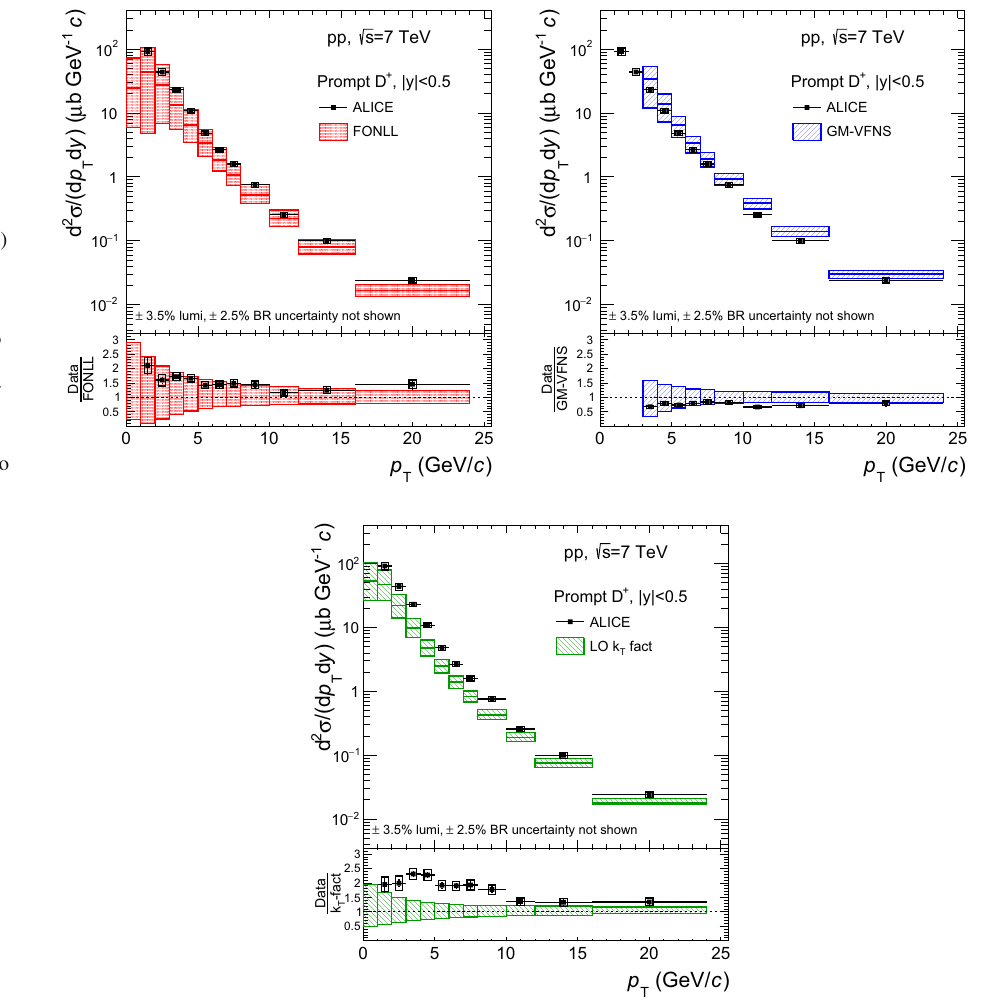
Fig. 5 p T -differential production cross section of prompt D + mesons with | y | < 0 . 5 in the interval 1 < p T < 24 GeV / c , in pp √ s = 7 TeV. The collisions at cross section is compared to three pQCD calculations: FONLL [7] ( top-left panel ), GM-VFNS [5] ( top-right panel ) and a leading order (LO) calculation based on k T -factorisation [9] ( bottom panel ). The ratios of the data to the three calculated cross sections are shown in the lower part of each panel . In